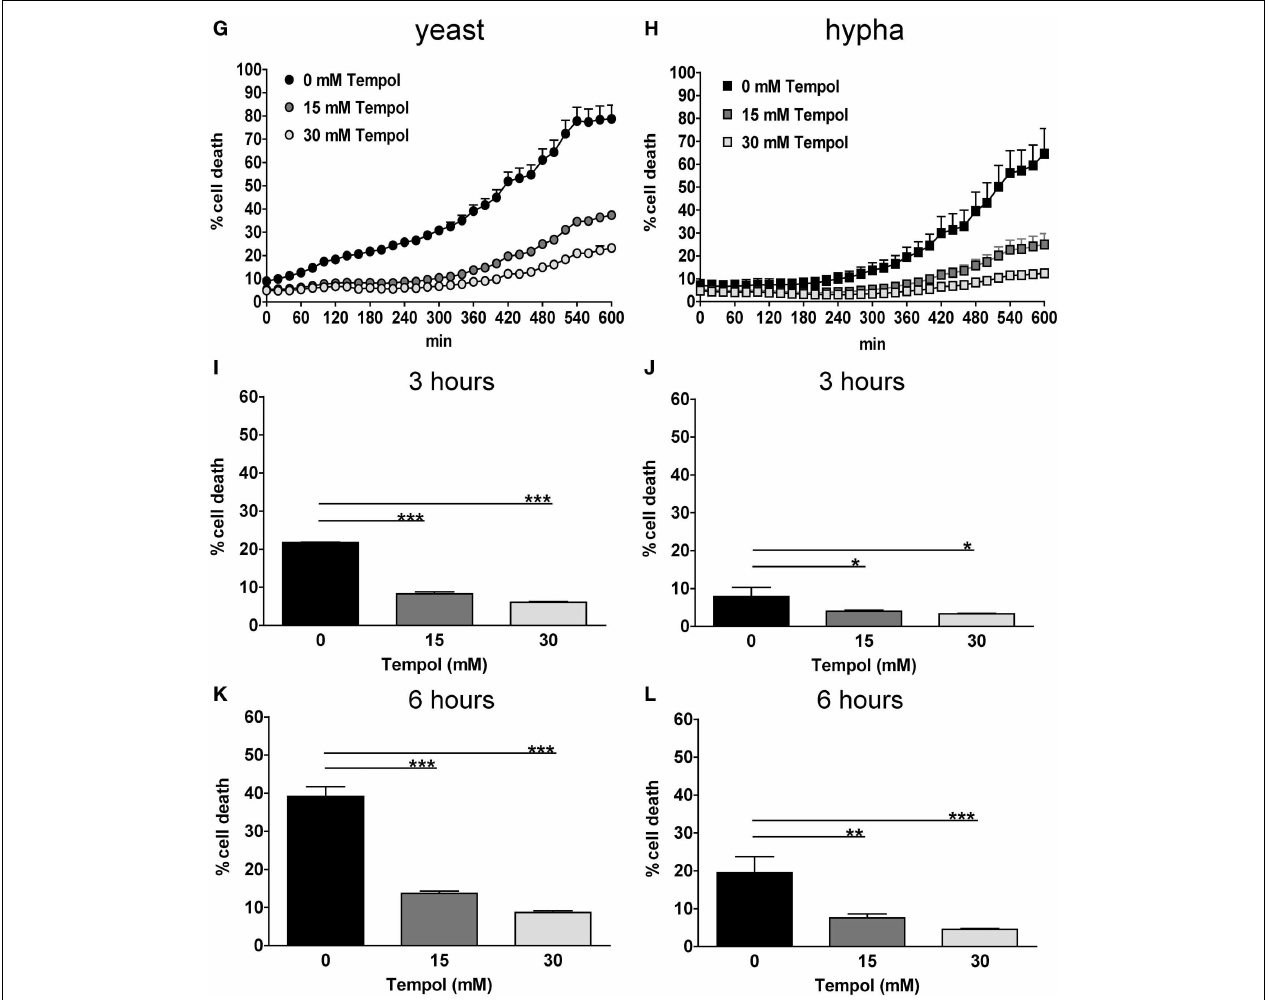
PMN cell death induced by yeast (A,G) or hyphal cells (B,H) of C. albicans (MOI 3). Black curves: PMNs infected with C. albicans , gray curves: PMNs treated with different concentrations ofTempol. Increasing concentrations of Tempol cause a reduction of PMN cell death upon infection with yeast (C,I) or hyphal cells (D,J) for 3h. Percentage of dead cells after 6h upon infection with yeast or (E,K) or hyphal cells of C. albicans (F,L) . Significance was analyzed byTukey one-way ANOVA (NS: P > 0.05, * P ≤ 0.05, ** P ≤ 0.01, and *** P ≤ 0.001). Data are presented as means of three technical replicates ±